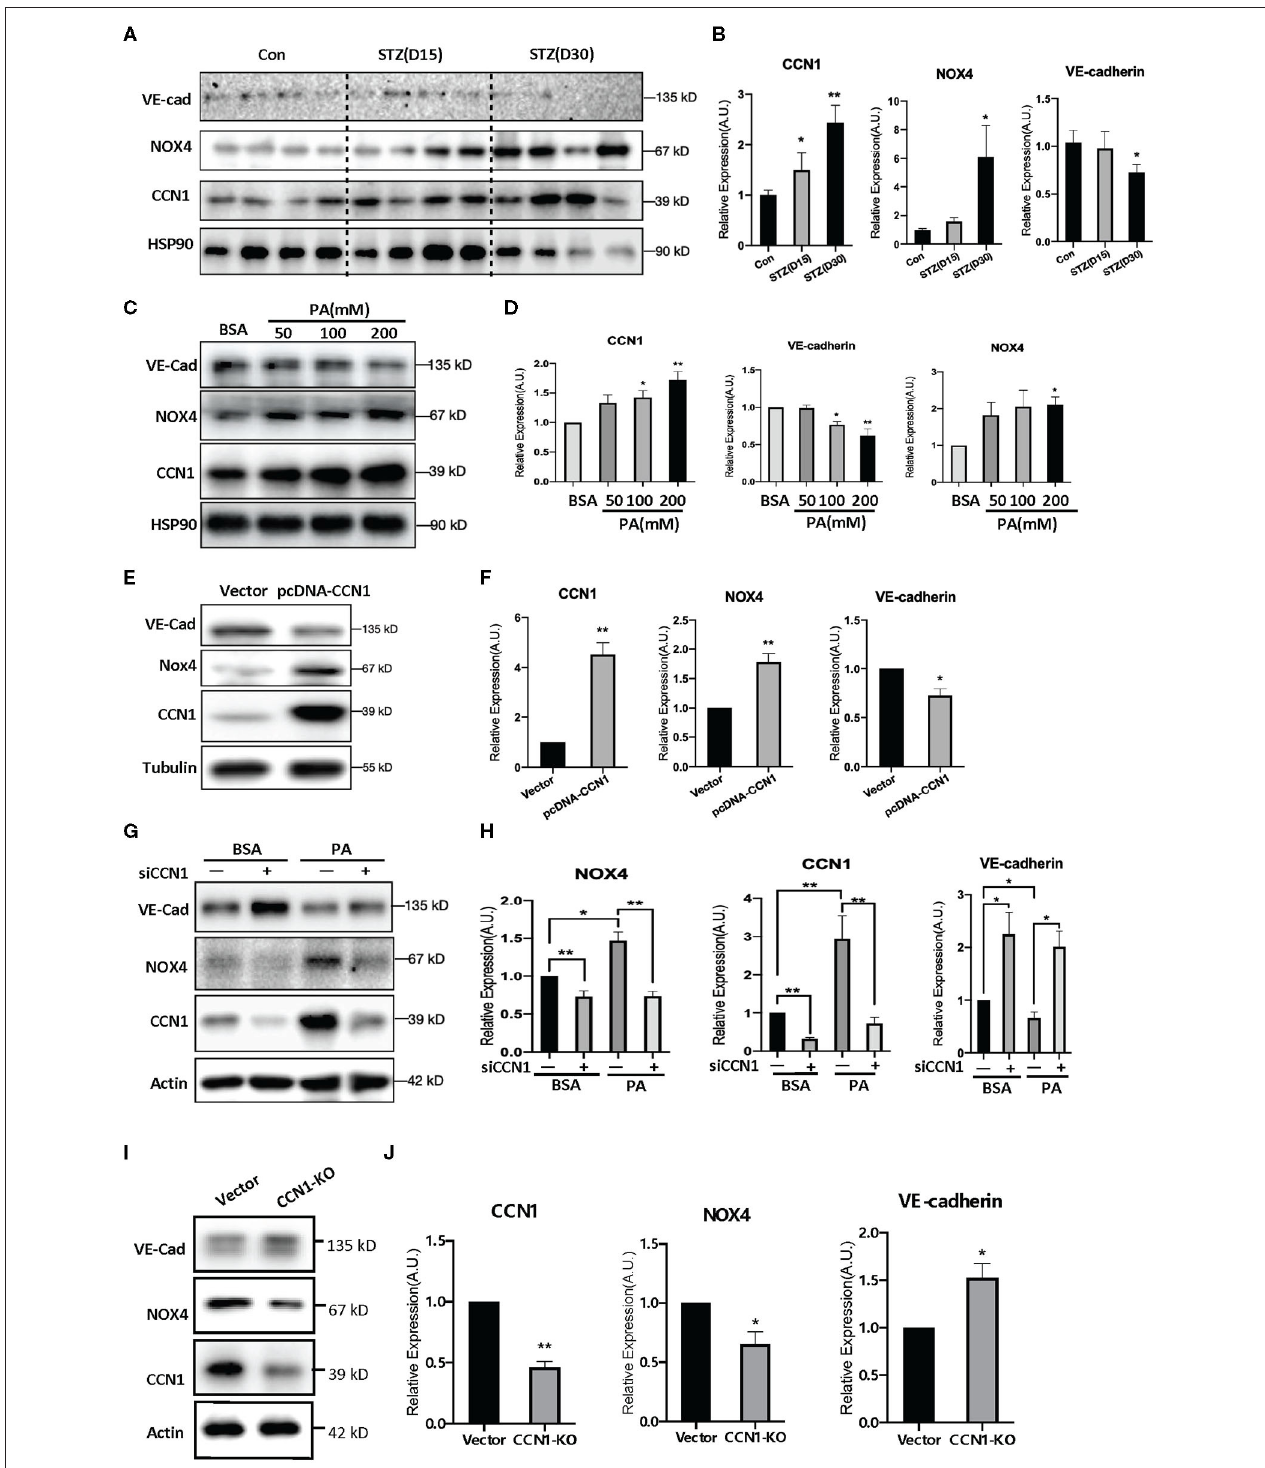
FIGURE 5 | NADPH oxidase (NOX4) mediates the negative regulatory effects of CCN1 on VE-cadherin expression. (A,C,E,G,I) Western blot analysis and (B,D,F,H,J) densitometry quantification of protein expression levels of VE-cadherin, NOX4, and CCN1 in (A,B) retina tissue of control mice and streptozotocin (STZ)-induced hyperglycemic mice on days 15 and 30 after modeling; (C,D) human retinal vascular endothelial cells (HRVECs) treated with serial dosages (50, 100, or 200mM) of palmitic acid (PA) for 24h; (E,F) HRVECs transfected with CCN1 plasmids or vector; (G,H) HRVECs transfected with siCCN1 or the negative control (siNC), followed by treatment with 100mM PA or BSA for 24h; (I,J) CCN1-KO HRVECs via CRISPR. * p < 0.05, ** p < 0.01.